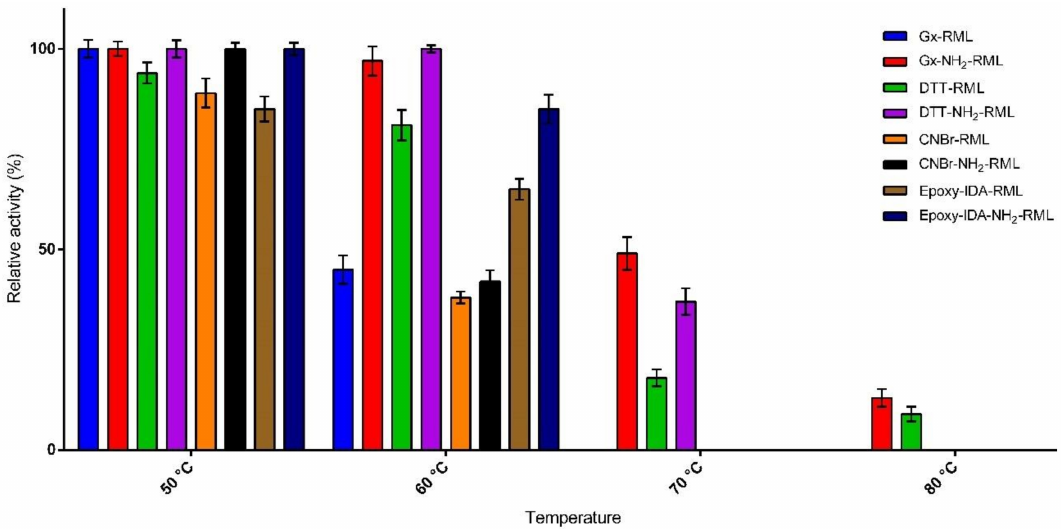
Figure 2. Thermal stability of the immobilized preparations upon incubation at di ff erent temperatures for 24